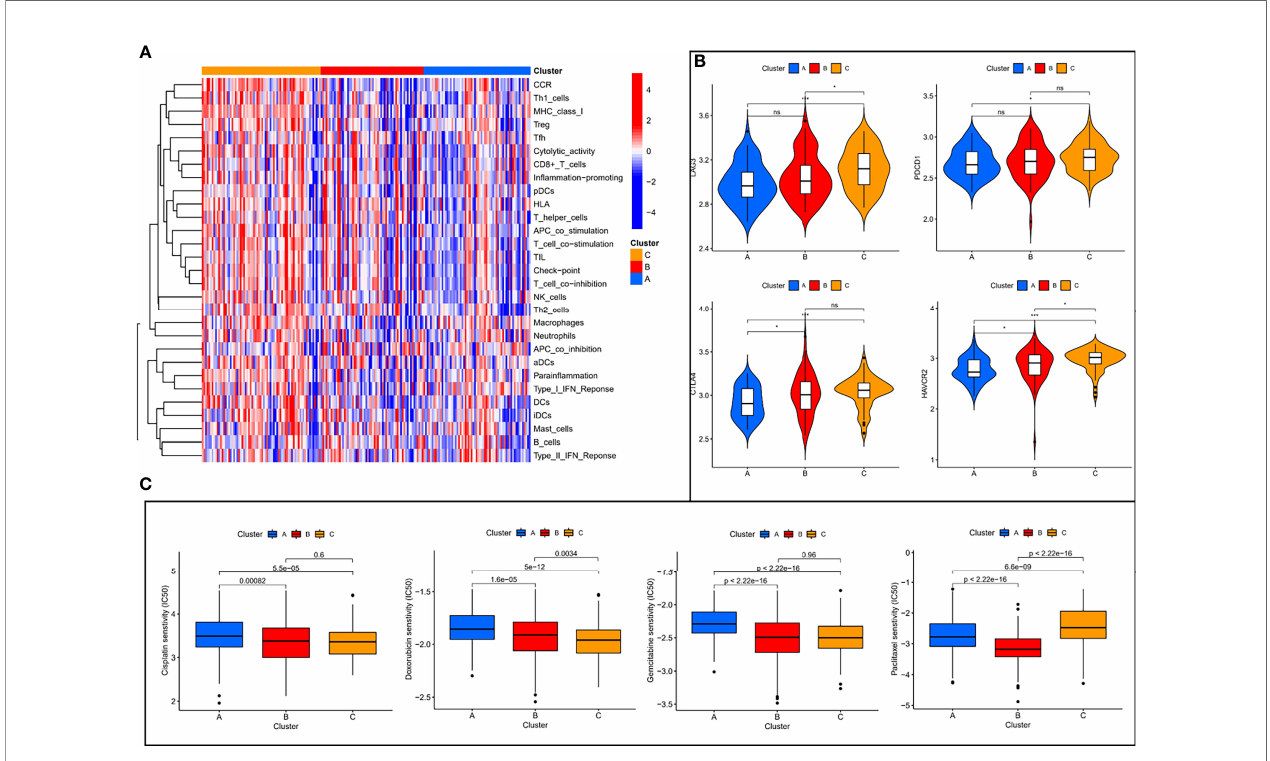
FIGURE 3 | Immune characterization analysis and drug sensitivity analysis of molecular subtypes. (A) The expression of immune function between different subtypes. (B) The expression levels of immune checkpoint genes between different subtypes. (C) The boxplot of sensitivity of common chemotherapy drugs in different subtypes. ns, not signi fi cant, * P < 0.05, ** P < 0.01, *** P <